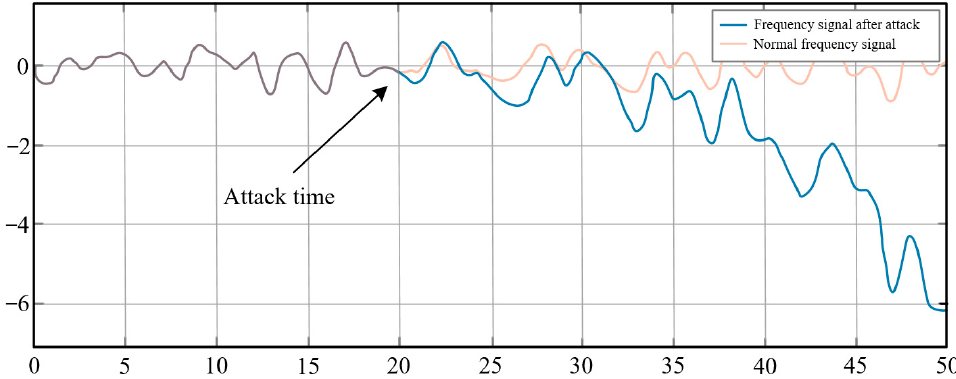
Figure 4. Change in system frequency deviation signal after being attacked by medium-strength negative compensation ACE signal in the 20th s.